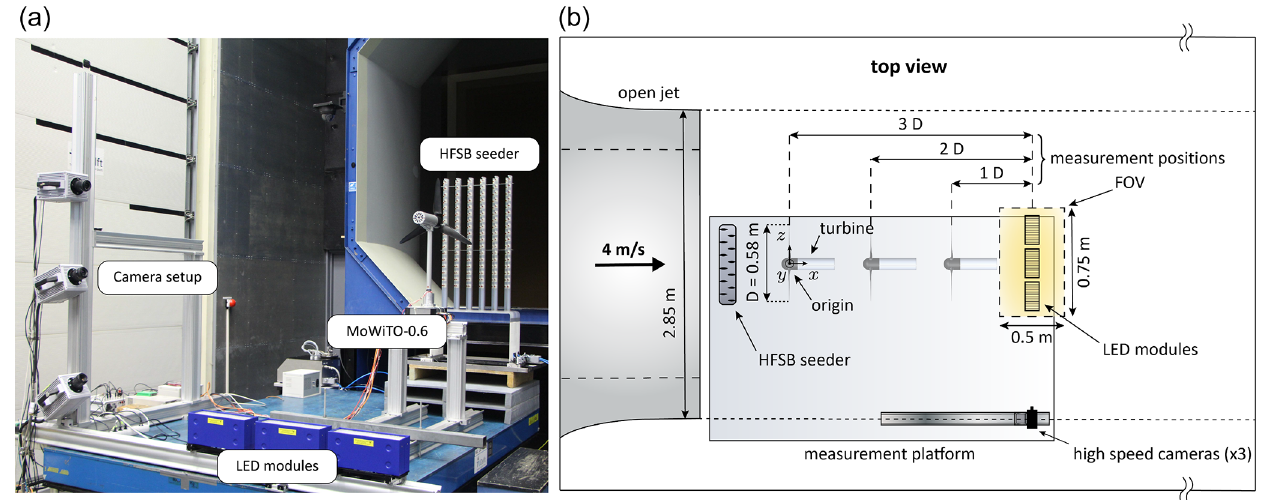
Figure 4. Experimental setup for measuring the wake using particle image velocimetry (a) and a schematic overview of the setup highlighting the different components and turbine locations used for measuring the wake (b)